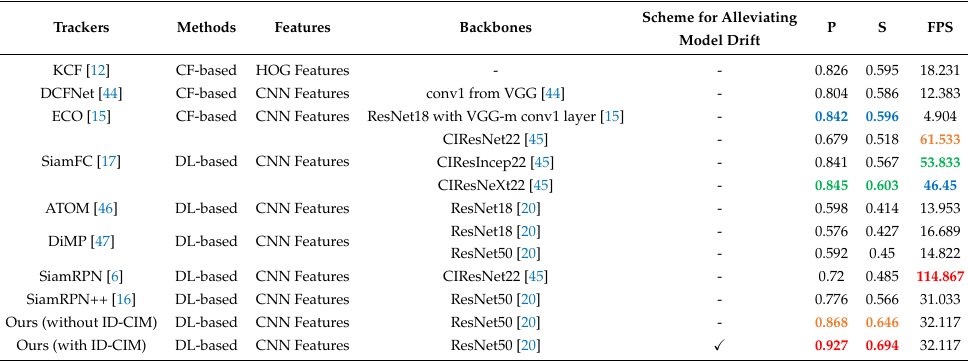
Table 5. The network details and comparison results of the